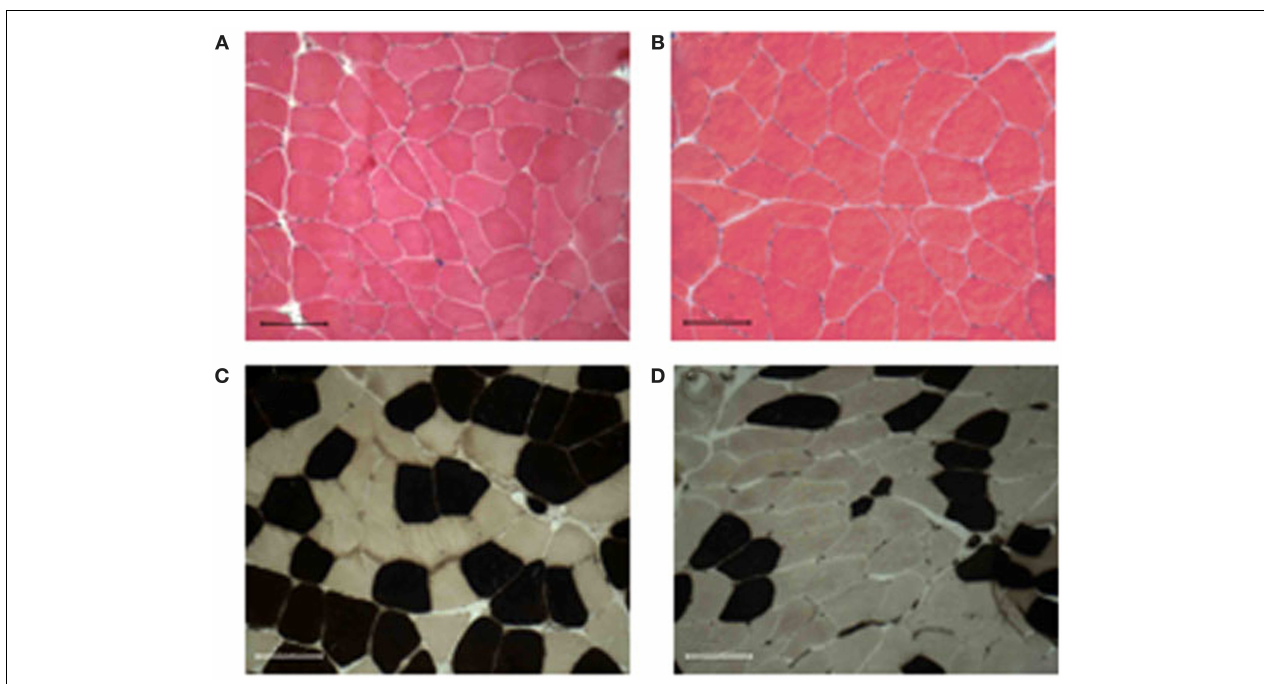
FIGURE 1 | Muscle morphology and fiber-type distribution . All muscle biopsies present well-packed myofibers, without signs of fibrosis, and inflammatory cell infiltration before (A) or after 9weeks of training (B) .The training induced an increase of either diameter and percentage of the fast-type fibers [brown stained (C,D) ]. Bar 100 µ m.